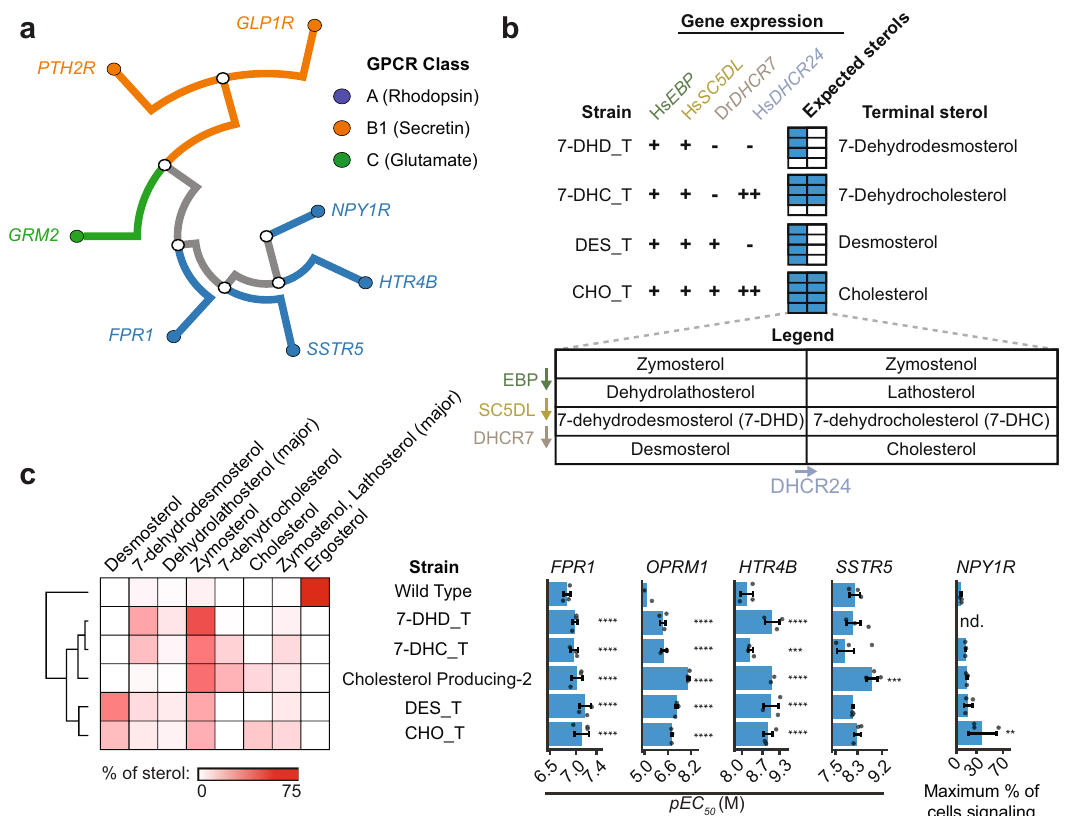
Fig. 7 Effect of cholesterol on the activity of different human GPCRs. a Phylogenetic relationships of the GPCRs tested. b Strains, designated by their terminal sterol, were built to produce all sterols up to the indicated terminal sterols by introducing sterol biosynthetic genes under native ergosterol promoters ( + ) or strong yeast promoters ( ++ ) in a erg2/3/5/6 biosensor background. ( − ) indicates no gene is present. The expected sterol space is diagrammed in the expected sterols legend. c Sterol pro fi les of strains with the indicated sterol backgrounds were determined. Biosensors based on expressing HTR4B, FPR1, OPRM1, SSTR5, and NPY1R in all sterol backgrounds were assayed in the presence of their agonists by fl ow cytometry to construct dose-response curves used to determine pEC 50 s and the maximum percent of cells signaling. Where responses were too weak to determine pEC 50 , maximum percent of cells signaling is reported. Data presented as mean + / − SD. Unpaired one-way ANOVA: n = 3 biologically independent experiments except n = 2 for HTR4B in Cholesterol Producing-2 and OPRM1 in Wild Type; >10,000 cells/strain/replicate; P < 2.2e − 16 for HTR4B , FPR1 , OPRM1 , SSTR5 assays, P = 0.02518 for NPY1R assay. Dunnett ’ s tests against WT shown. *, P < 0.05; **, P < 0.01; ***, P < 0.001; ****, P < 0.0001. OPRM1 , Wild Type, and OPRM1 , Cholesterol Producing-2 data are replotted from Fig. 6c. Source data are provided as a Source Data fi